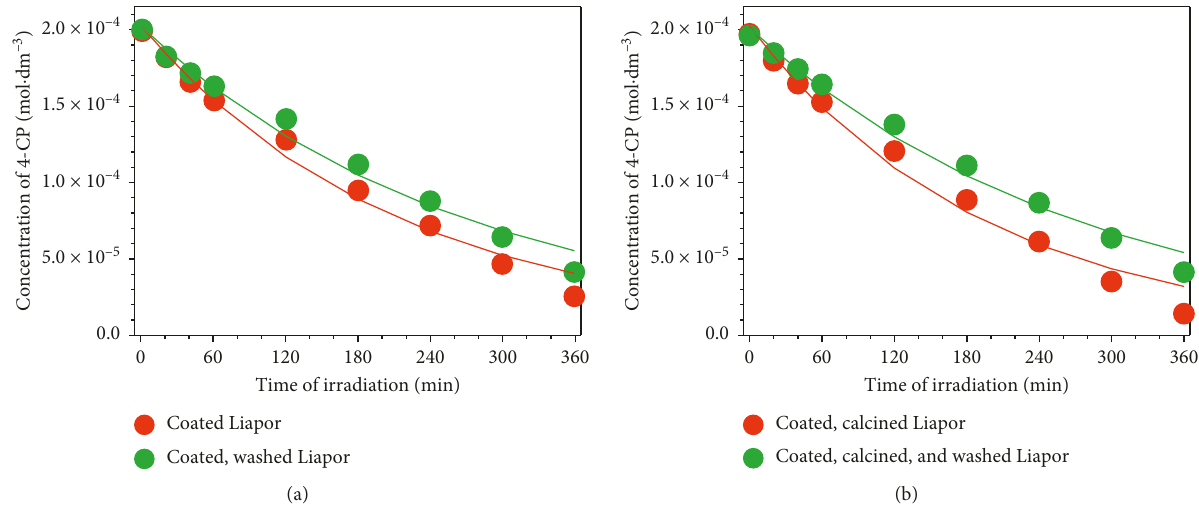
Figure 5: Photocatalytic degradation of 4-CP (in laboratory photoreactor at a stirring rate of 500 rpm) using (a) nonwashed and washed Liapor. (b) Calcined, and calcined, washed Liapor. Table 2: Rate constants of 4-CP photocatalytic degradation and relative change of TOC after 6 hours of irradiation.